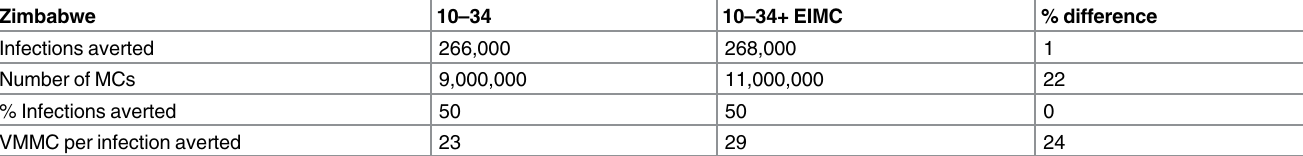
Table 3. Impact of Adding EIMC on HIV Infection Rates.